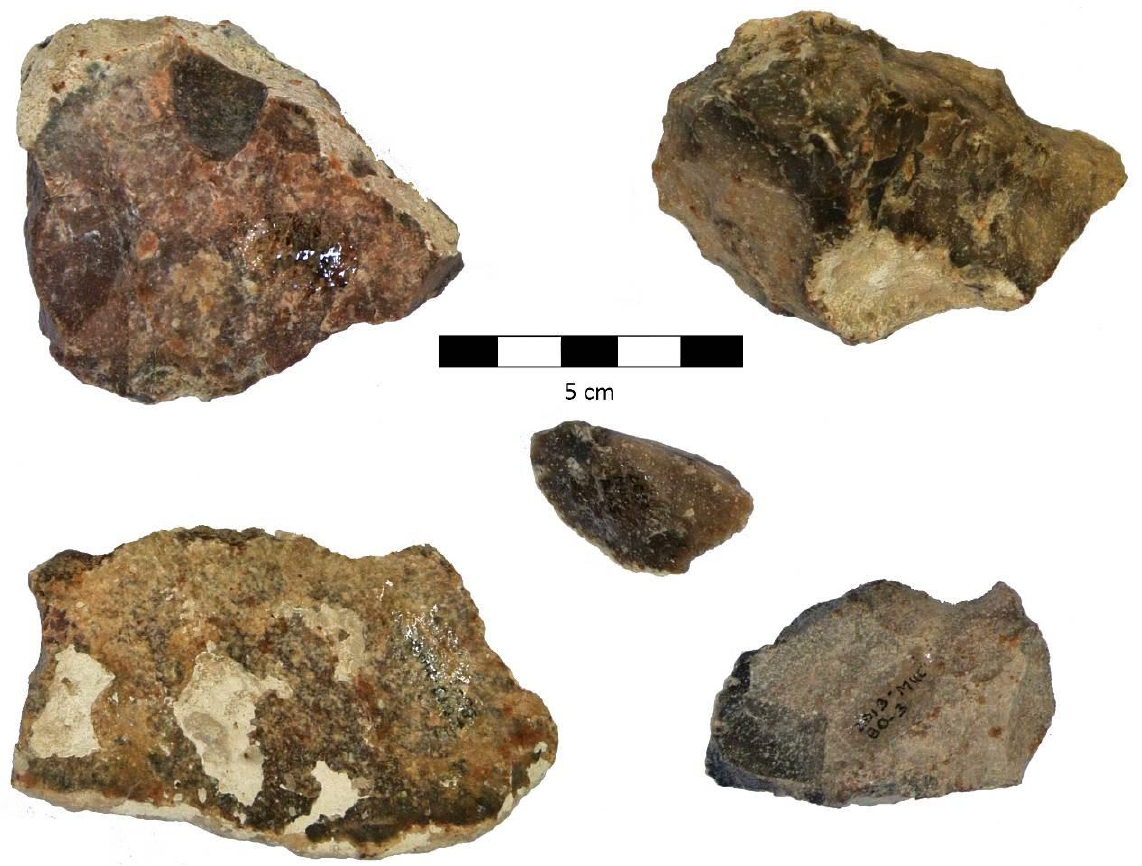
Figure 8. Materials from